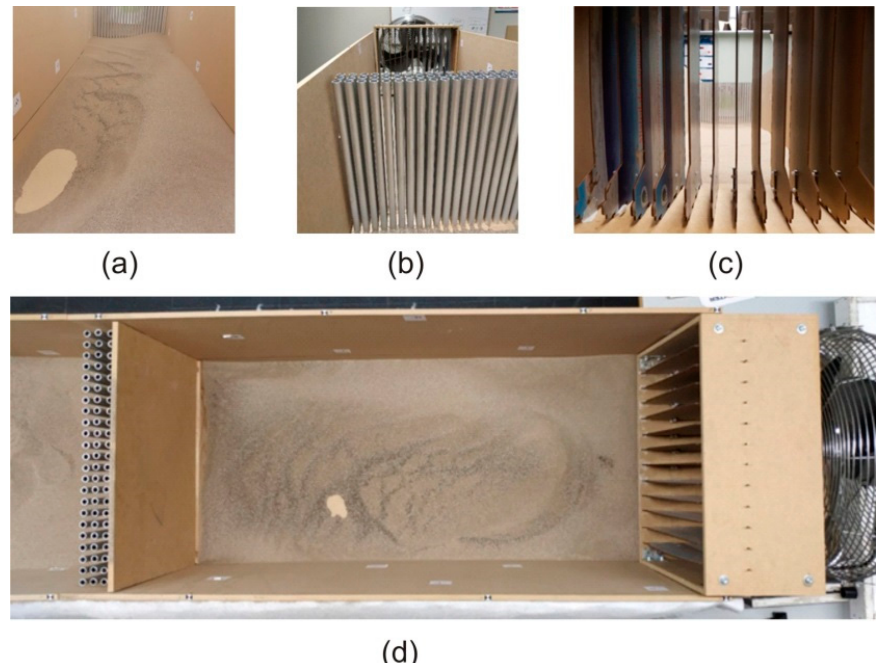
Figure 5. ( a ) Accumulation of sand on the right side of the tunnel caused by the turbulences of the fan blades before the insertion of the diffuser; ( b ) Front view of the diffuser in the final assembly; ( c ) Back view of the diffuser placed in the tunnel; ( d ) Plant view of the scaled wind tunnel.